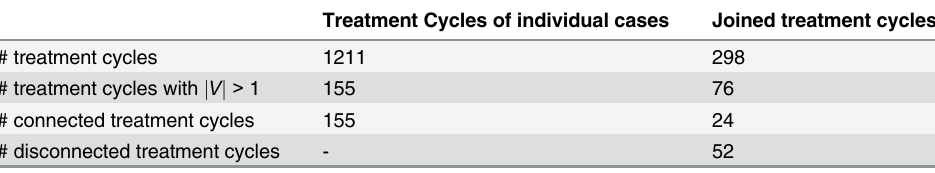
Table 3. Number of the connected and disconnected treatment cycles inferred from the data. Treatment Cycles of individual cases